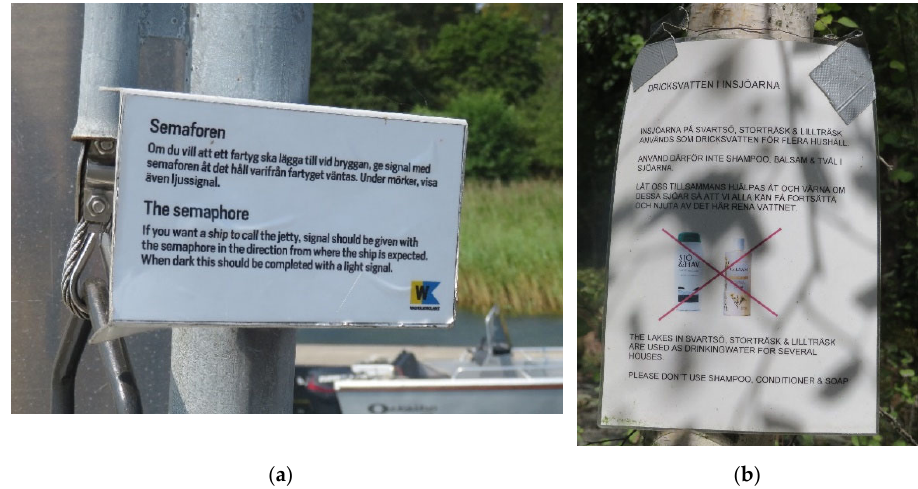
Figure 1. English in the linguistic landscape: ( a ) The semaphore at the jetty in Solvik on Nämdö; ( b ) a home ‐ made sign found by the road on Svartsö.